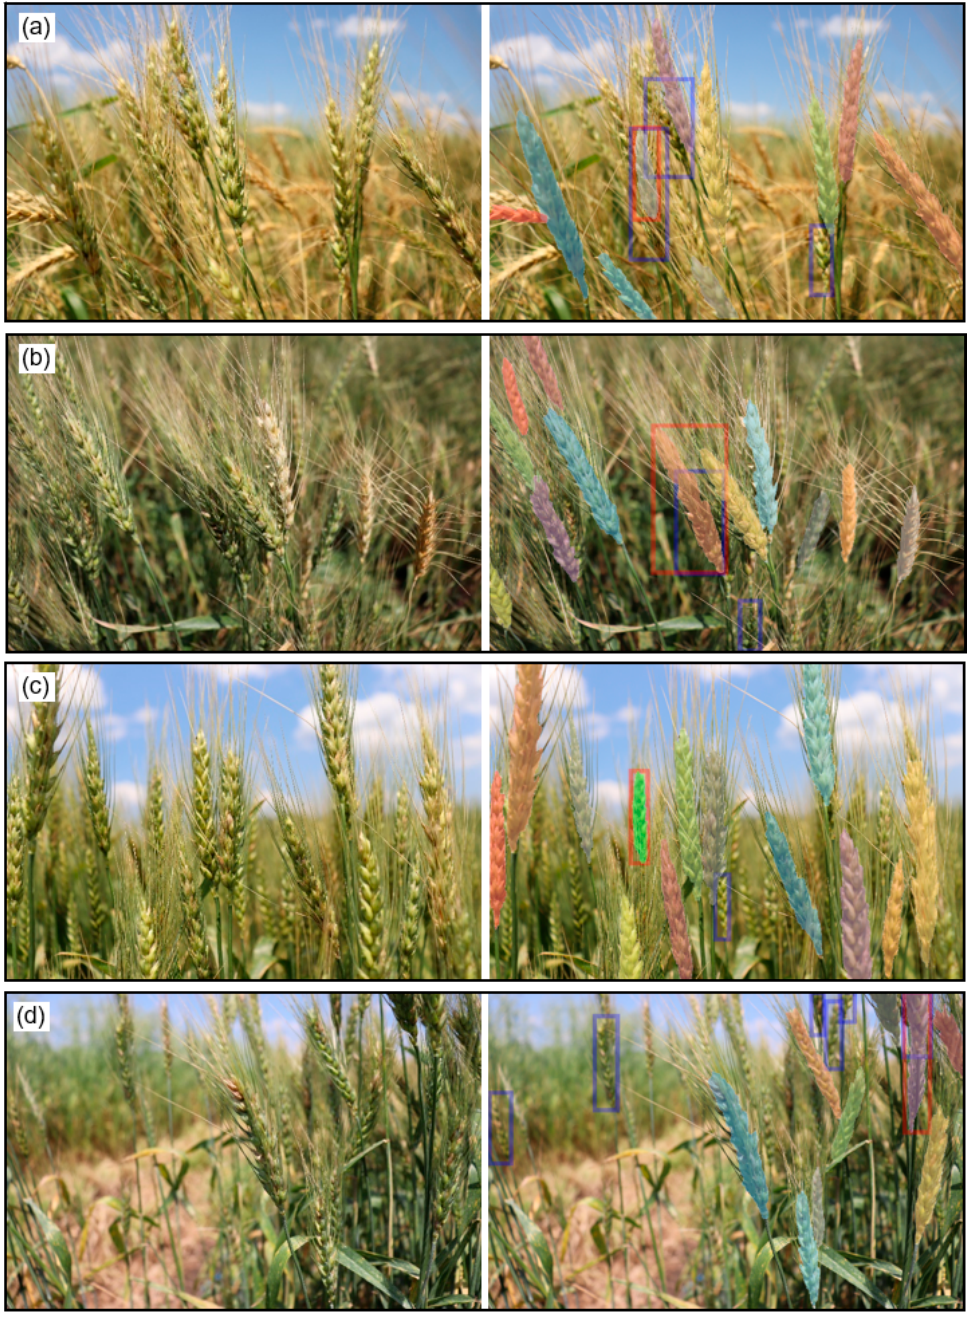
Figure 6. ( a – d ) Various examples of wheat spike detections in the validation dataset; the spike with the blue box rectangle only has the ground truth (a.k.a. is labeled) with no prediction results (a.k.a. is missed), which is a false negative, while the spike with the red rectangle only has the prediction result (a.k.a. is detected) with no ground truth (a.k.a. is not labeled), which is false positive.